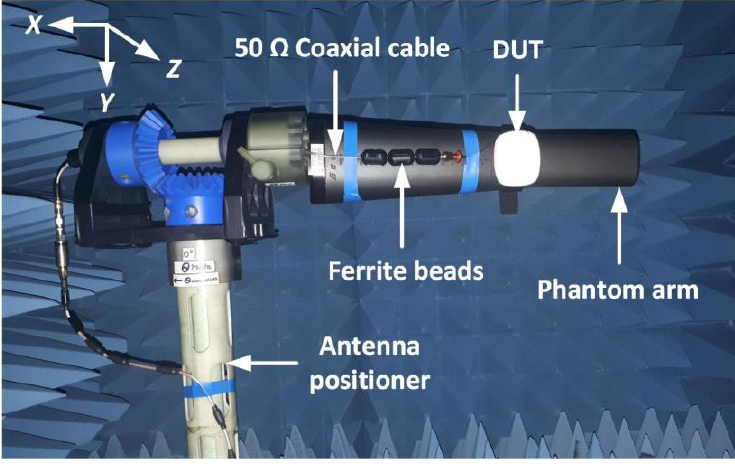
Figure 15. Device under test (DUT) measurement setup in AMS-8050 anechoic chamber [76] .